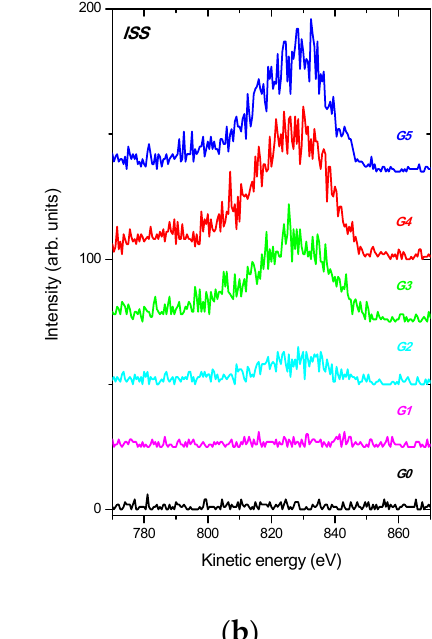
Figure 3. Percentage of Ge species in a surface region of the samples derived from XPS spectra evaluated from ID = 6 nm and 2 nm ( a ). Low energy ion scattering spectra (ID < 1 nm) recorded from undoped DLC G0 and Ge-doped DLC G1 − G5 samples, ascribed to 4He ion beam scattering at Ge atoms ( b